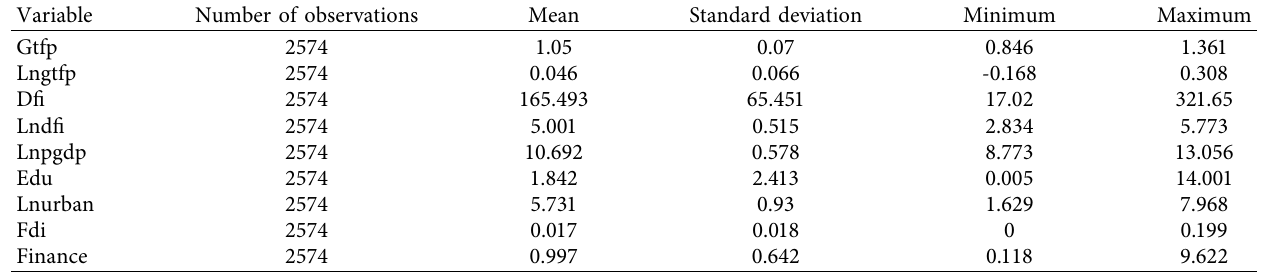
Table 1: Descriptive statistics.